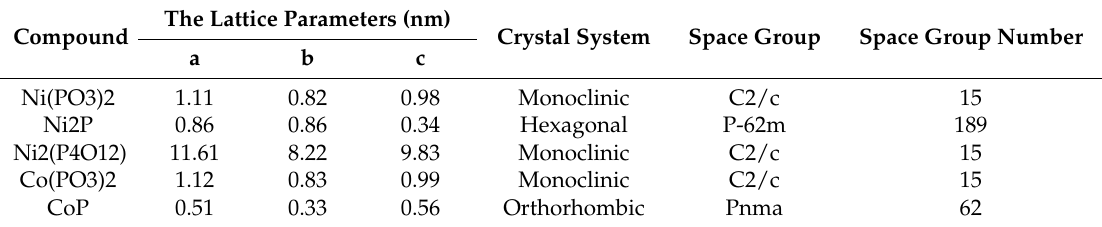
Table 4. Lists the crystallographic parameters of identified compounds in the Ni-CMC and Co-CMC. The Lattice Parameters (nm) Compound